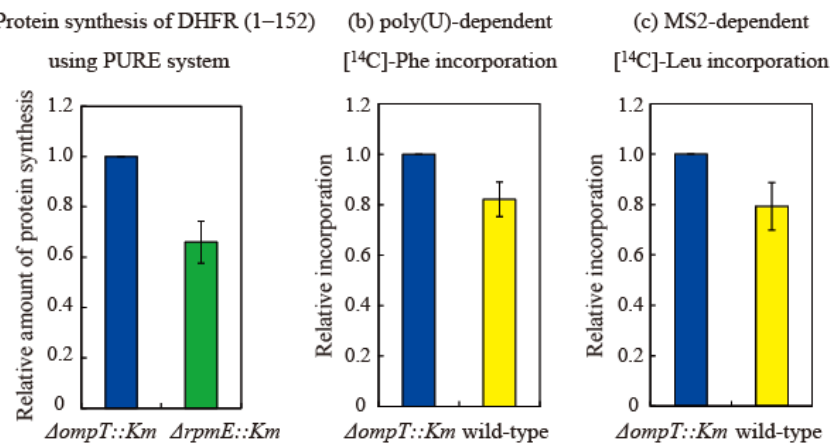
Figure 7. Translational activity of ribosomes containing short bL31 is lower than that of ribosomes containing intact bL31. ( a ) Synthesis of DHFR (1–152) is 40% lower in Δ rpmE::Km HSRs than in Δ ompT::Km HSRs. Synthesis of DHFR (1–152) using the PURE system [27] was performed in vitro using HSRs containing exclusively intact bL31 (from Δ ompT::Km cells) or no bL31 (from Δ rpmE::Km cells). After the electrophoresis of reaction mixtures on 10–20% SDS-PAGE gels, the synthesized DHFR (1–152) was visualized using CBB. The density of the DHFR (1–152) band was normalized against that of the r-protein band. Protein synthesis was normalized against synthesis using HSRs containing only intact bL31 (i.e., Δ ompT::Km ). The data are averages of four independent pure system reactions and two PAGE gels per reaction (a total of eight gels). ( b , c ) Translational activity in vitro is 20% lower in wild-type HSRs than in Δ ompT::Km HSRs. ( b ) Poly(U)-dependent L-[U- 14 C] phenylalanine incorporation and ( c ) MS2-dependent L-[U- 14 C] leucine incorporation were per- formed in vitro using HSRs containing only intact bL31 ( Δ ompT::Km ) or both intact and short bL31s (wild-type). Protein synthesis was normalized against synthesis using HSRs containing only intact bL31 (i.e., Δ ompT::Km ). Net incorporation of L-[U- 14 C] Phe ( b ) and L-[U- 14 C] Leu ( c ) using control Δ ompT::Km HSRs was equivalent to 35.6 and 1.0 nmol, respectively. Relative amounts of protein synthesis using HSRs of Δ ompT::Km, Δ rpmE::Km , and the wild type are shown by the midnight blue, green, and yellow bars, respectively. The data represent the averages of three independent experi- ments.